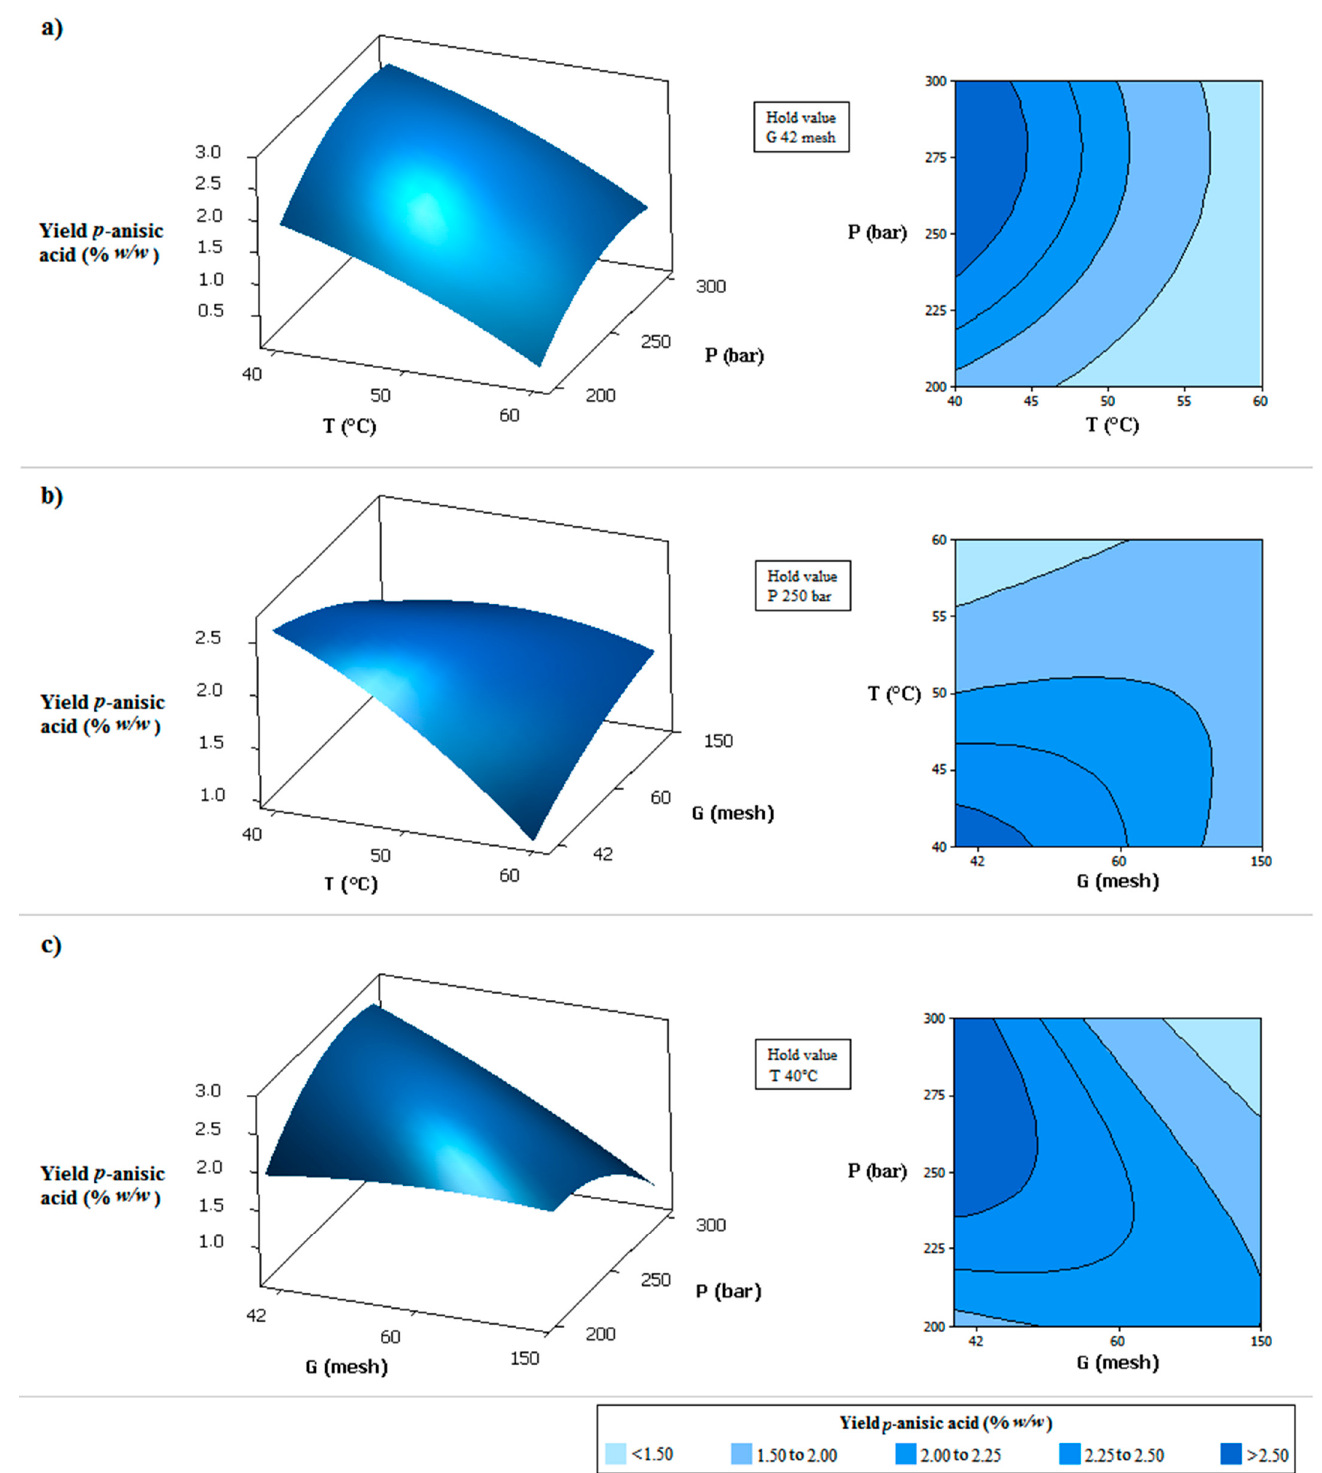
Figure 2. Response surfaces and contour plots for effects of two independent variables on the yield of p -anisic acid in the extract obtained by supercritical extraction: ( a ) CO 2 pressure (P) and CO 2 temperature (T); ( b ) CO 2 temperature (T) and medium particle size of milled flowers (G); ( c ) CO 2 pressure (P) and medium particle size of milled flowers (G).